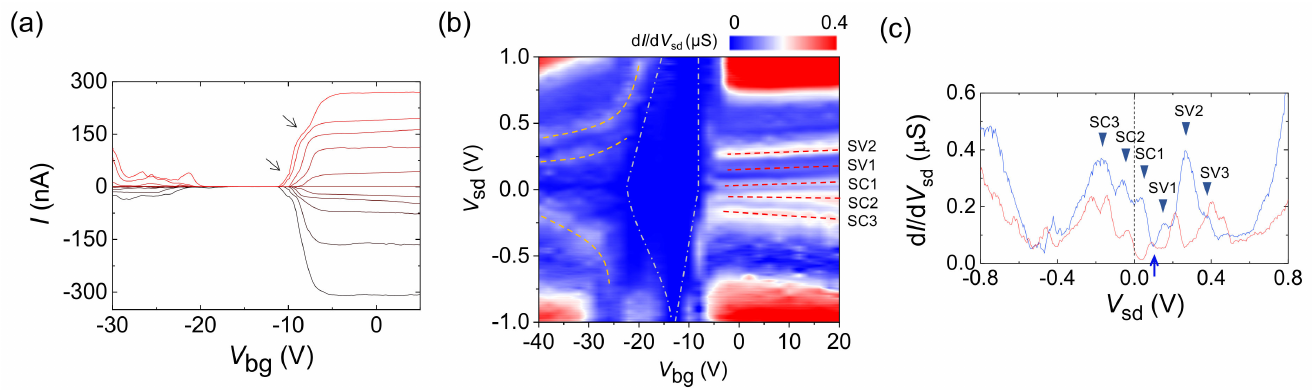
Figure 5. ( a ) Transfer curve for an sm -MWCNT ( L ≈ 2.1 µ m, D ≈ 3 nm) at T = 4.2 K for various V sd values from 0.75 V (top) to − 0.75 V (bottom) in steps of 0.15 V. Arrows indicate the current steps, originated from the DOS-sensitive transport. ( b ) d I /d V sd map as a function of V sd and V bg . The dashed curves trace the observed conductance peaks, and the white dash-dotted lines correspond to the boundaries of the depletion region. ( c ) d I /d V sd as a function of V sd at V bg = 0 V (blue curve) and − 40 V (red curve), where SC n (SV n ) is the n th subband in the conduction (valence)